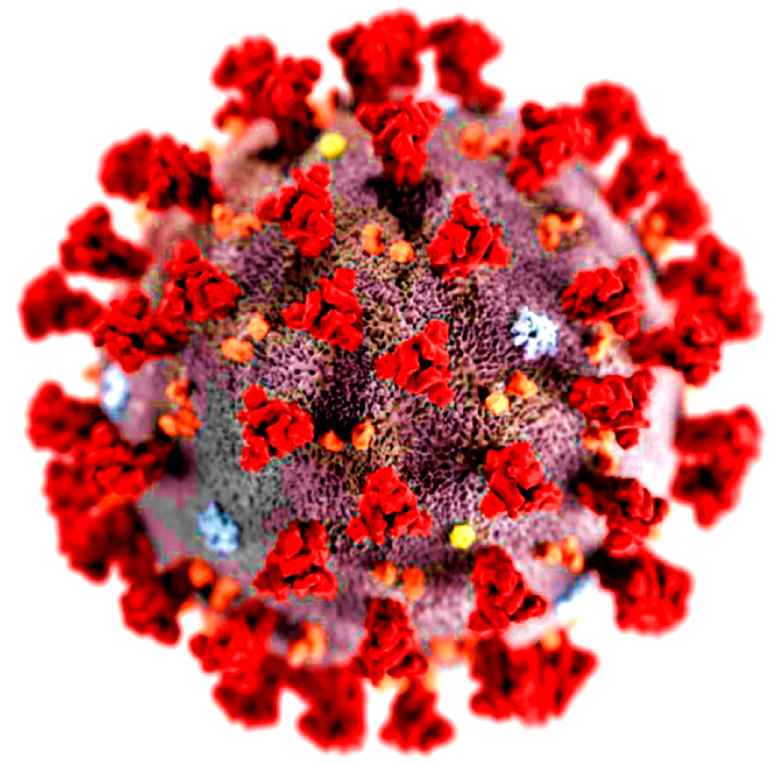
Figure 3. Visualization of SARS-CoV-2 virus.